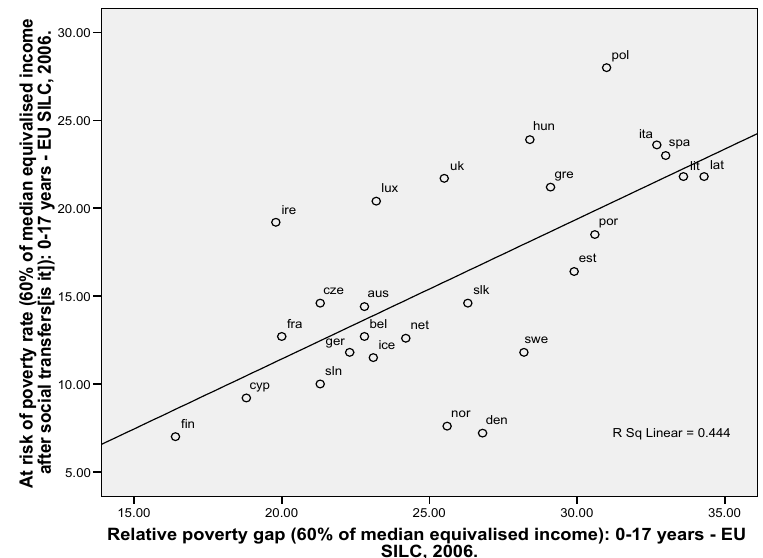
Figure 8 : Child poverty rate by child poverty gaps